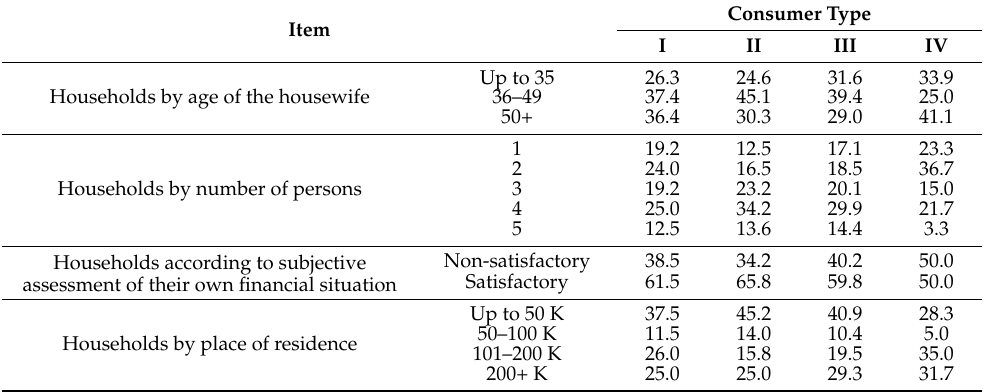
Table 6. Characteristics of Polish consumers’ households ( n = 600, in